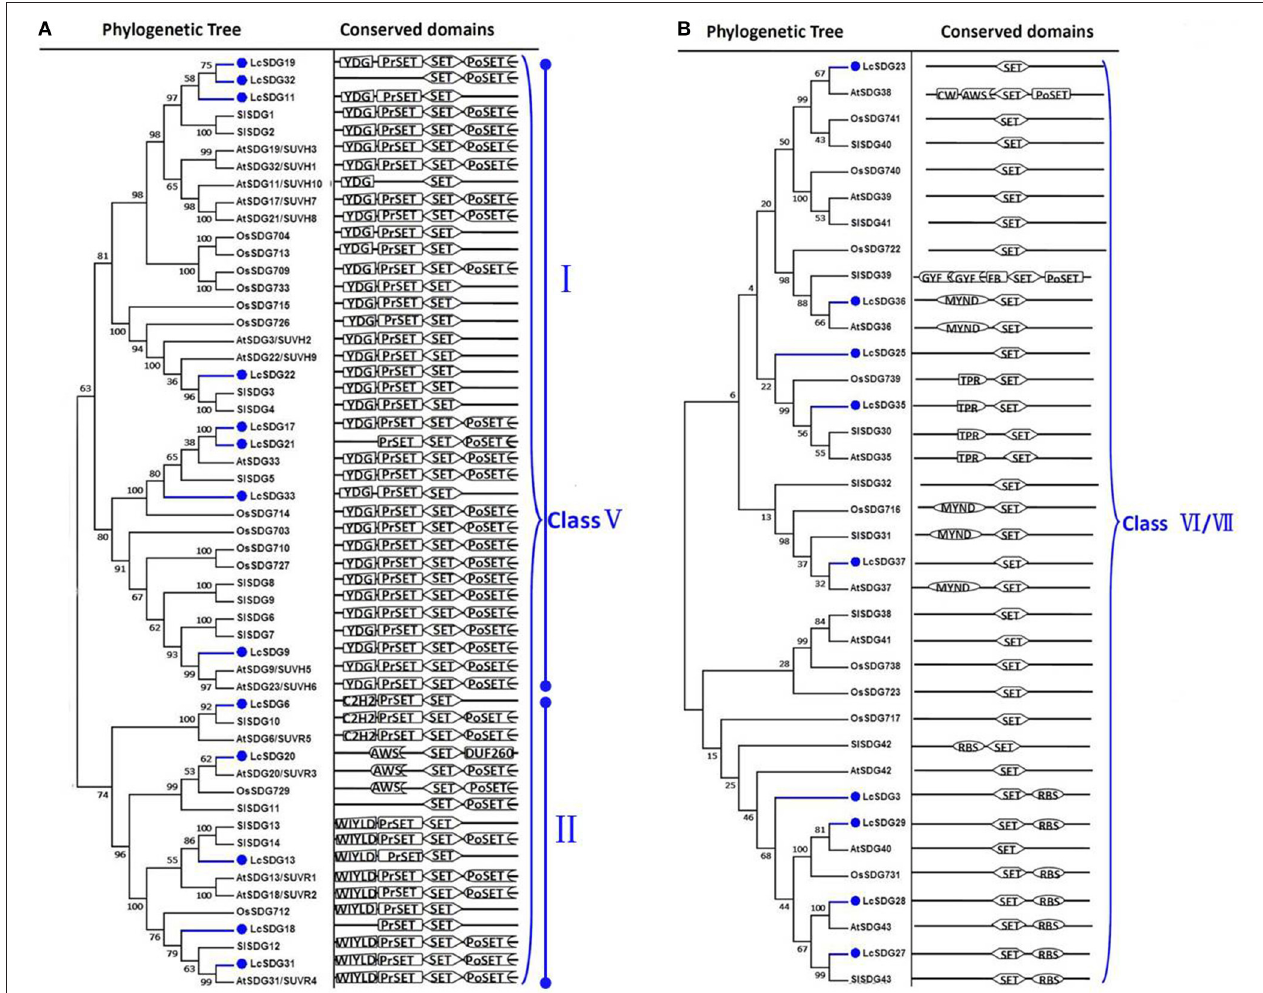
FIGURE 5 | Maximum likelihood phylogenetic trees and schematic diagrams for domain composition of class V and class VI/VII HMT proteins predicted from Litchi chinensis (Lc), Arabidopsis thaliana (At), Oryza sativa (Os) , and Solanum lycopersicon (Sl). (A) Phylogenetic tree and schematic diagrams for domain composition of class V which are further divided into two groups. N-terminal YDG (PF02182), Pre-SET, SET, and Post-SET are conserved domains of the group I of Class V; N-terminal WIYLD (PF10440), or C2H2 (PF00096) or absence of domain, Pre-SET, SET, and Post-SET are conserved domains of the group II of Class V. (B) Phylogenetic tree and schematic diagrams for domain composition of class VI/VII HMT proteins. Some members of these two classed comprised N-terminal AWS, or GYF, or TPR, or MYND domain, while some members included C-terminal RBS domain. The phylogenetic tree was constructed based on the amino acids sequences with 1,000 bootstrapping